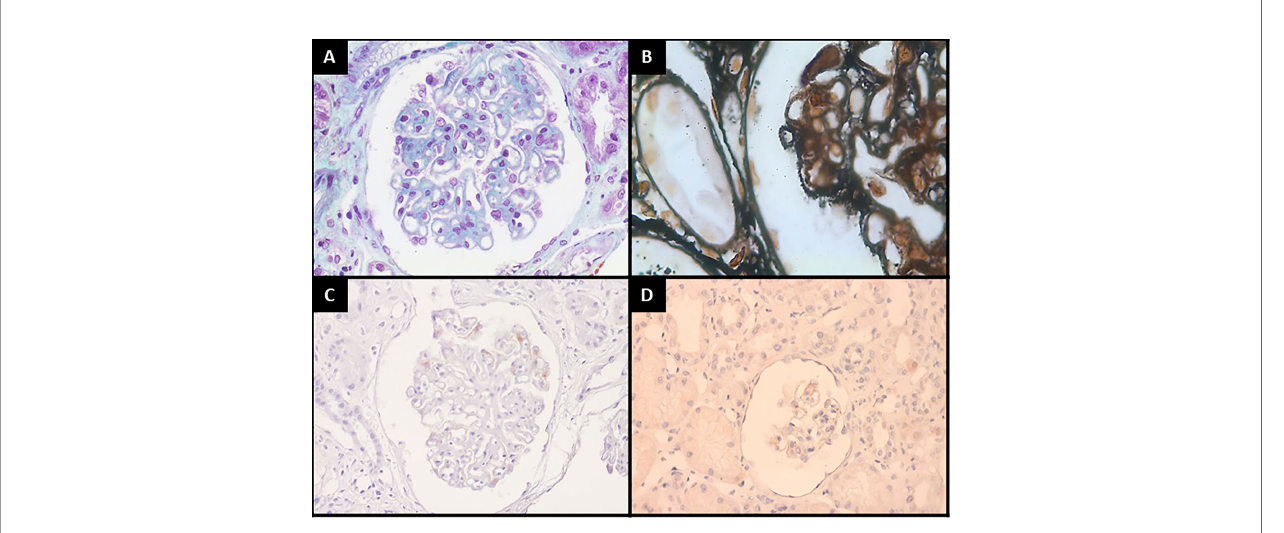
FIGURE 1 | Kidney biopsy fi ndings: (A) Global glomerular basement membrane thickening (Masson ’ s Trichrome, 400×). (B) Glomerular characteristic deposits forming “ spikes ” and “ chain links ” fi gures (periodic acid methenamine, 1,000×). (C) PLA2R immunohistochemical stain revealing no immunoreactivity (400×). (D) Some glomeruli show weak and segmental staining for thyroglobulin along the glomerular capillary